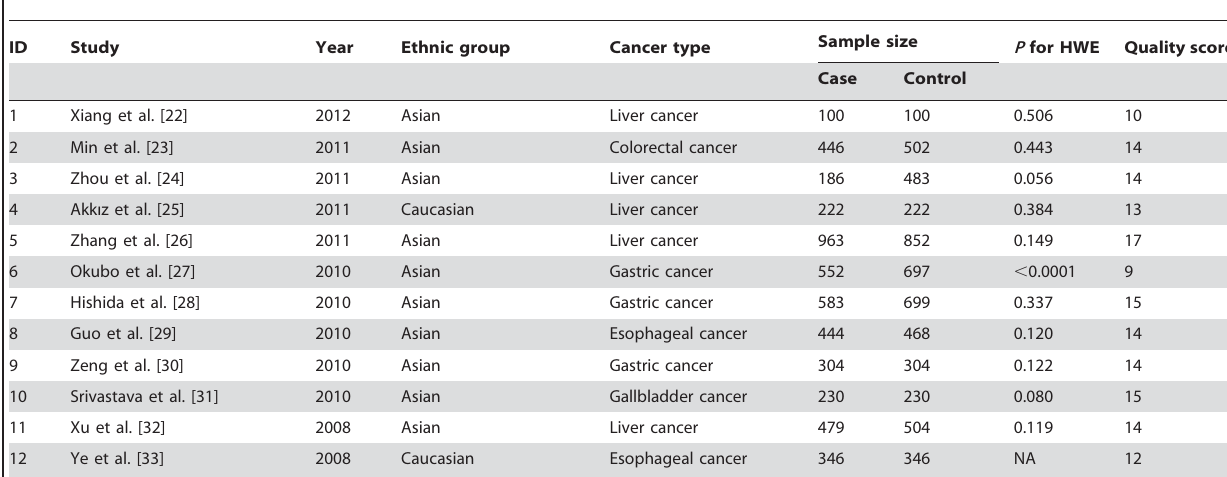
Table 2. Characteristics of studies included in the